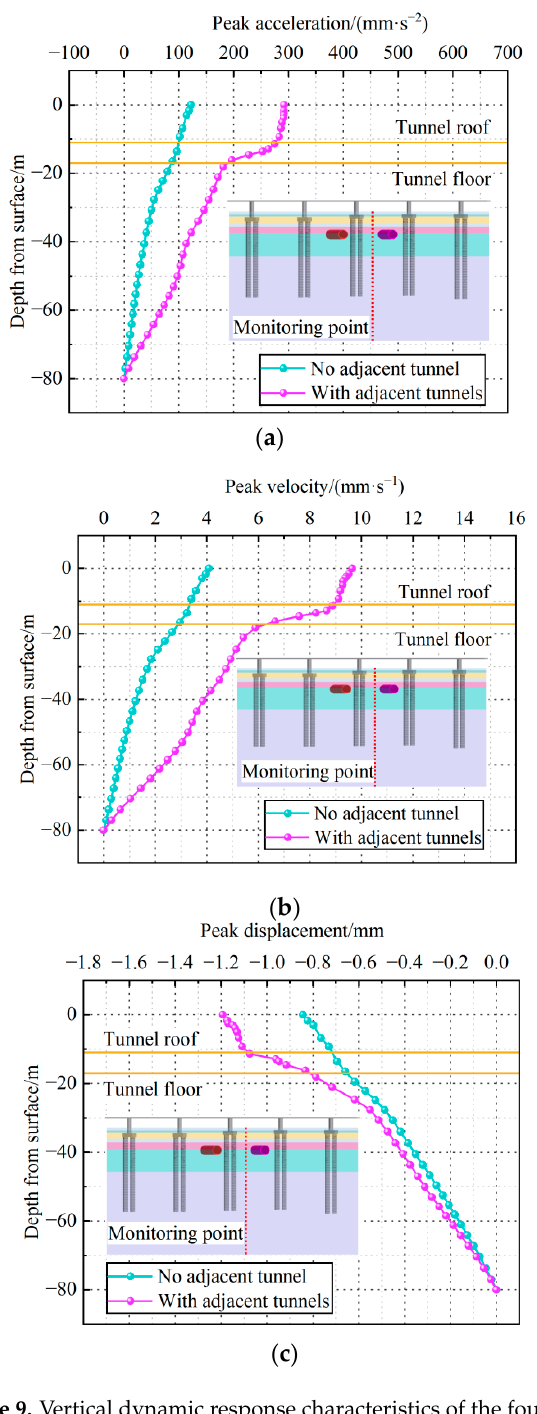
Figure 9. Vertical dynamic response characteristics of the foundation. ( a ) Peak vibration acceleration. ( b ) Peak vibration velocity. ( c ) Peak vibration displacement.